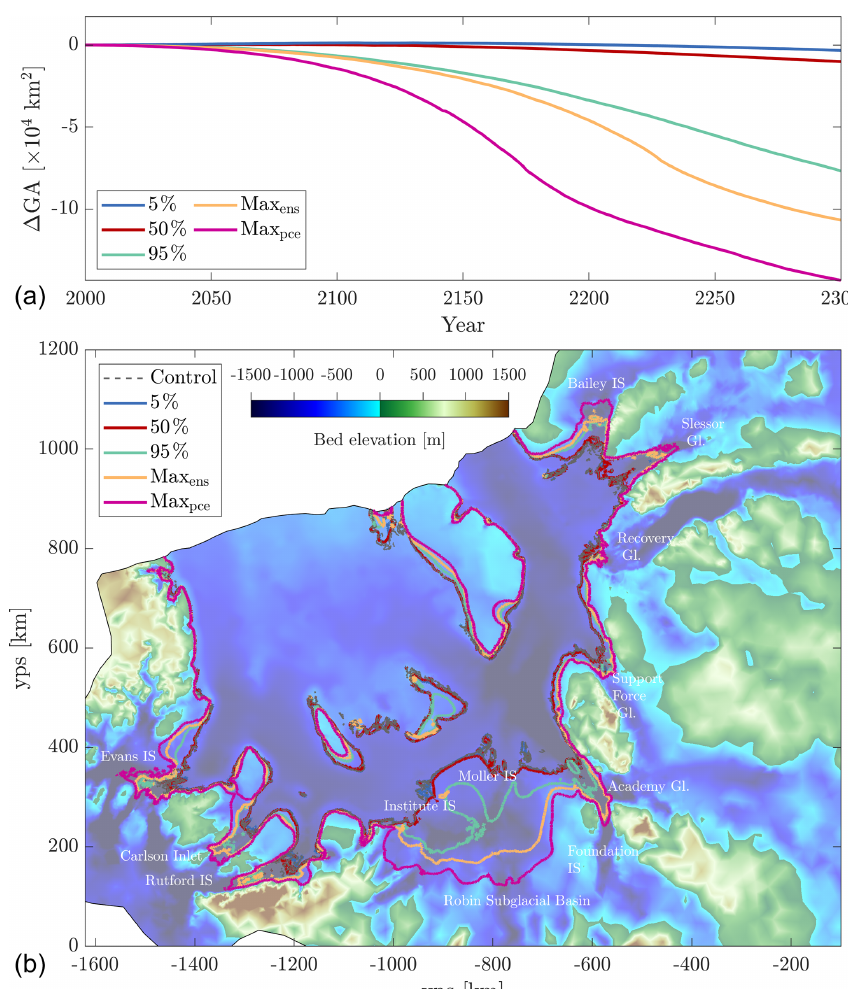
Figure 9. Changes in grounded area and grounding line position for RCP8.5. Panel (a) shows change in grounded area ( (cid:49) GA calculated as GA rcp − GA ctrl ) in × 10 4 km 2 . Coloured lines represent the 5th, 50th, and 95th percentiles of the projections of (cid:49) GMSL rather than the percentiles of the change in grounded area itself. However, they are generally close to the grounded area results. Panel (b) shows the FR basin and bed elevation in metres above (green to brown) and below (light to dark blue) sea level. Coloured lines show grounding line positions from our training ensemble that lie closest to our percentiles (5%, 50%, and 95%) from our surrogate model projections, with respect to control runs (dashed grey lines). Two additional grounding line positions are shown; the maximum (cid:49) GMSL from our training ensemble (orange) and the maximum (cid:49) GMSL from our surrogate model (magenta), which we evaluated separately to our initial training ensemble of